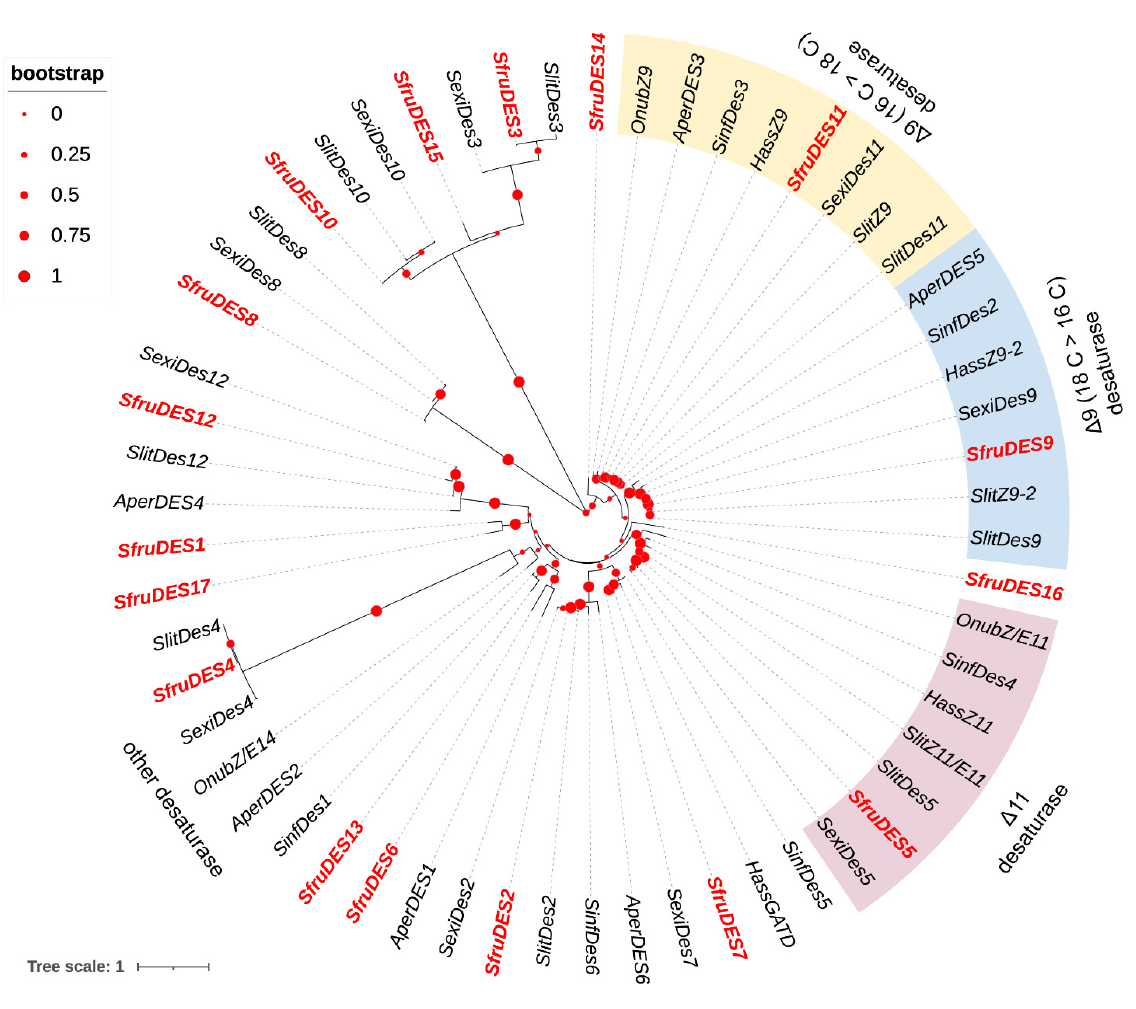
Figure 2. Phylogenetic tree of insect desaturase (DES). The S. frugiperda translated genes are shown in red. Sfru : S. frugiperda , Slit : S. litura , Sexi : S. exigua , Sinf : S. inferens , Aper : A. pernyi , Onub : O. nubilalis , Hass : H. assulta.